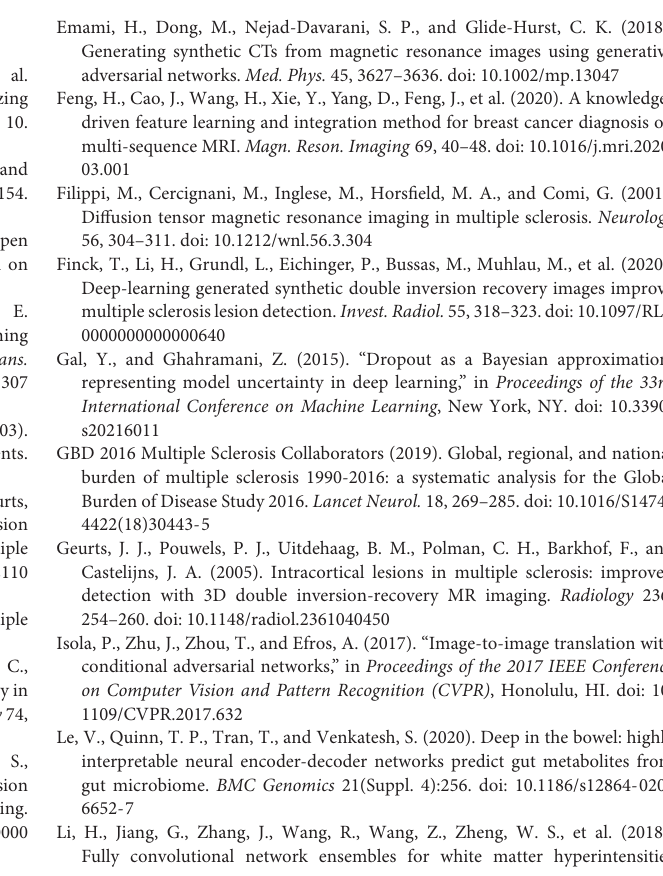
Supplementary Figure 1 | Network architecture: (A) The U-Net generator used to produce a synthetic DIR image from FLAIR and T1 input images. (B) The patch-based discriminator which receives as input both the source image (T1 and FLAIR) and either a real or synthetic DIR. The discriminator is patch-based. ks, kernel